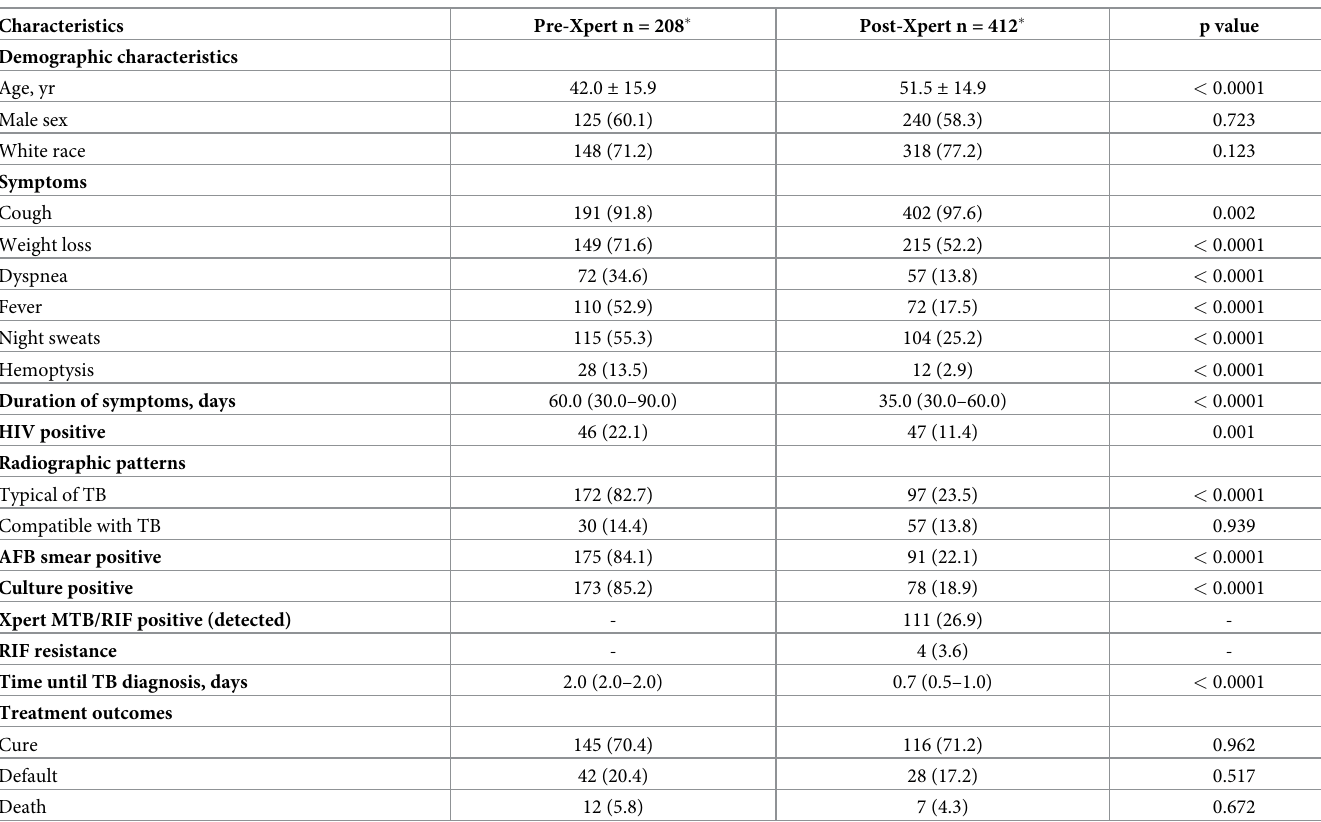
Table 1. Characteristics of study